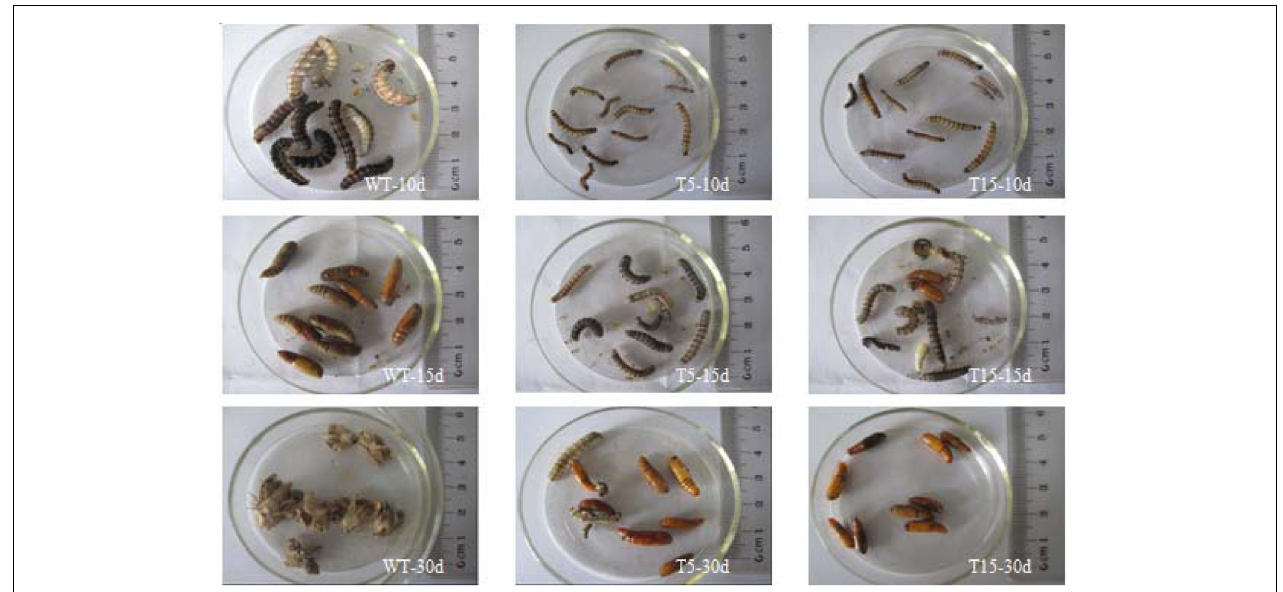
FIGURE 4 | Pupation and eclosion of larvae during feeding bioassay. WT-10d: 10 days after larvae fed by wild type stem tissue; WT-15d: 15 days after larvae fed by wild type stem tissue; WT-30d: 30 days after larvae fed by wild type stem tissue; The left three images shows that larvae feed by wild type stem tissue grow healthy and all larvae underwent eclosion in 30 days. T5-10d: 10 days after larvae fed by T5 stem tissue; T5-15d: 15 days after larvae fed by T5 stem tissue; T5-30d: 30 days after larvae fed by T5 stem tissue. The middle three images shows that larvae feed by T5 stem tissue grew slowly and small, the pupation and eclosion was delayed badly. T15-10d: 10 days after larvae fed by T15 stem tissue; T15-15d: 15 days after larvae fed by T15 stem tissue; T15-30d: 30 days after larvae fed by T15 stem tissue. The right three images shows that larvae feed by T5 stem tissue grew slowly and small, the pupation and eclosion was delayed badly.